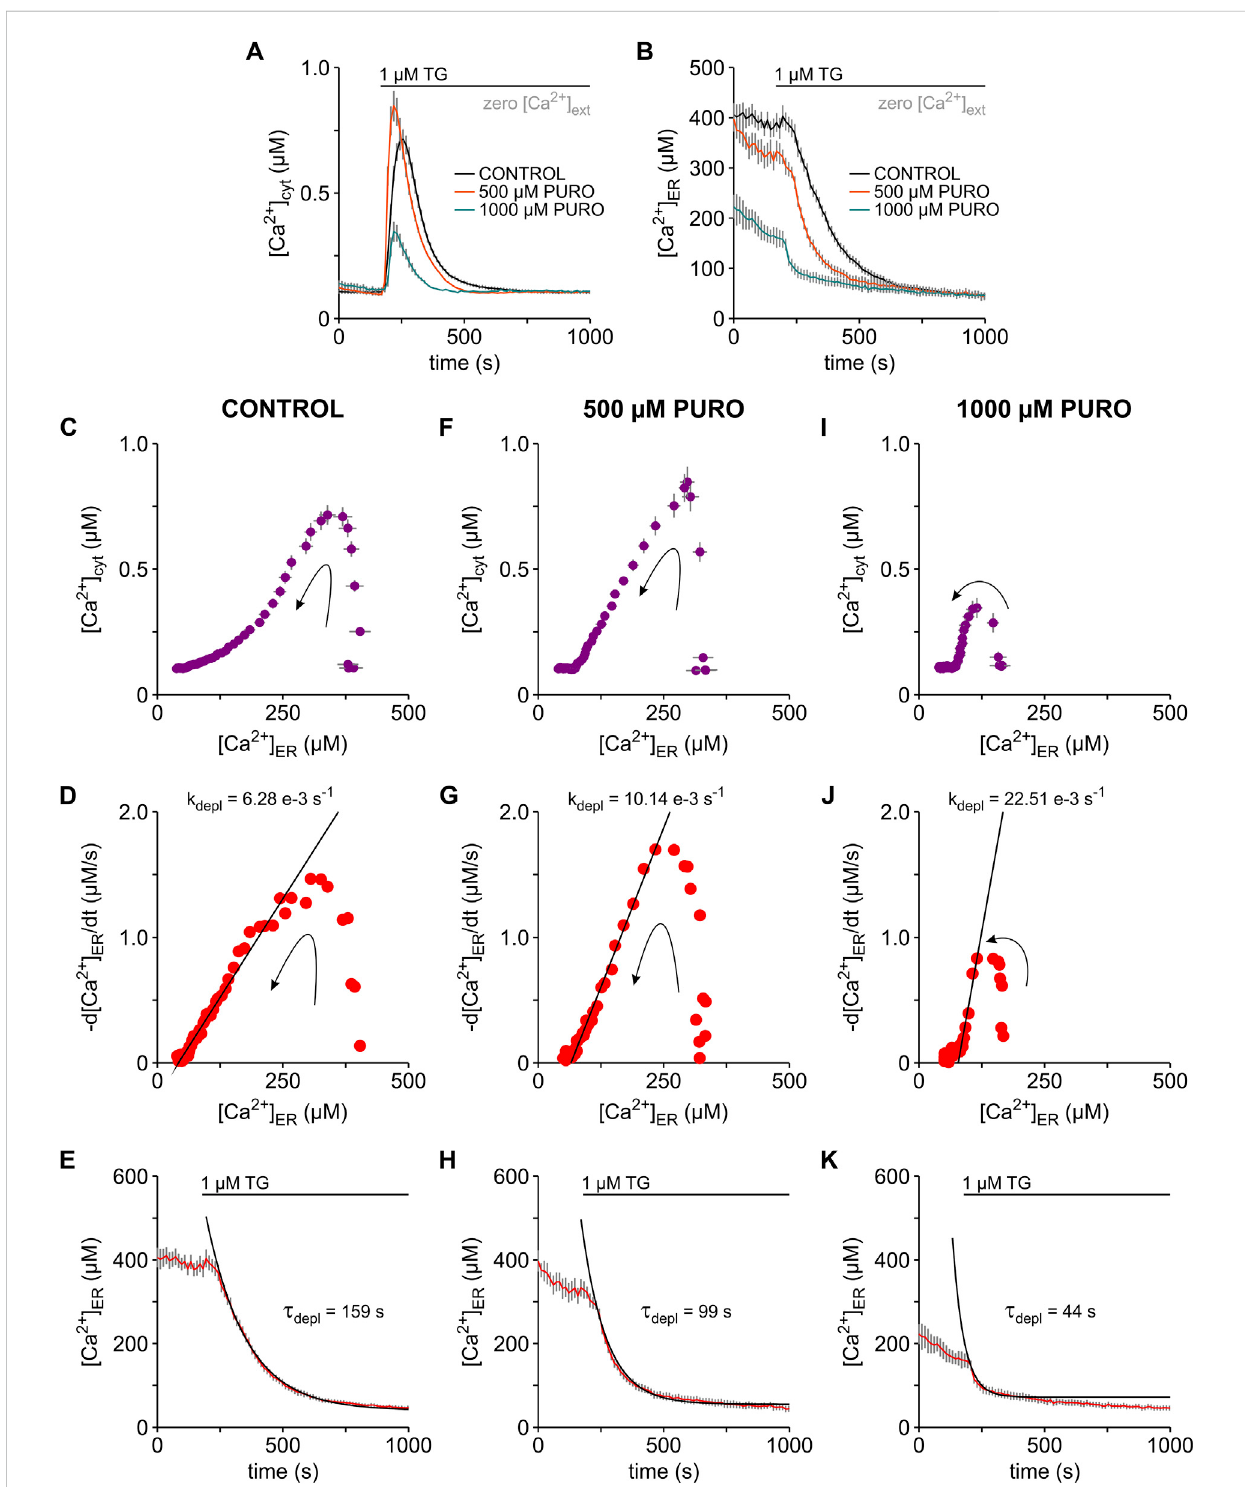
FIGURE 4 Puromycin effects on the TG-induced Ca 2+ mobilisation in HEK-D1ER cells. Cytosolic Ca 2+ ([Ca 2+ ] cyt ) and ER Ca 2+ ([Ca 2+ ] ER ) were imaged simultaneously with FURA-2 and D1ER in the HEK-D1ER cell line. Cells were exposed to 500 and 1000 µM puromycin (500 µM PURO, 1000 µM PURO) for10 mininasolutioncontaining2 mMCa 2+ (notshown).Controltreatment(CONTROL)wascarriedoutjustwiththe2 mMCa 2+ solution.Ca 2+ imaging recordings were performed in the absence of external Ca 2+ (zero [Ca 2+ ] ext ). Time courses of [Ca 2+ ] cyt (A) and [Ca 2+ ] ER (B) in control cells and after treatmentwith500 μ Mand1000 µMPURO.Forcontrol,500and1000 µMPUROtreatments,graphsshowthecorrelationbetween[Ca 2+ ] cyt and[Ca 2+ ] ER (C,F,I) , the dependence of the fi rst derivative of the ER Ca 2+ concentration (-d[Ca 2+ ] ER /dt) on [Ca 2+ ] ER (D,G,J) and the time course of the TG-induced ER Ca 2+ depletion (E,H,K) . The decaying phases in the plots shown in (D,G,J) were fi tted with linear relations (black lines), in which the leak rates (k depl ) were 6.28 e − 3, 10.14 e − 3 and 22.51 e − 3 s − 1 , respectively. τ depl values of 159, 99 and 44 s were calculated as the inverse of the corresponding k depl . Exponential functions (black lines) wereconstructed withthecalculated τ depl values and superimposed on thetime courses ofERCa 2+ depletion, as shown in (E,H,K) . Protocols ofTGapplication aredepicted abovethegraphs. Arrows indicate thetimecourseofevents (C,D,F,G,I,J) . Data isgivenas mean± SEM.Number of cells: 12 – 16